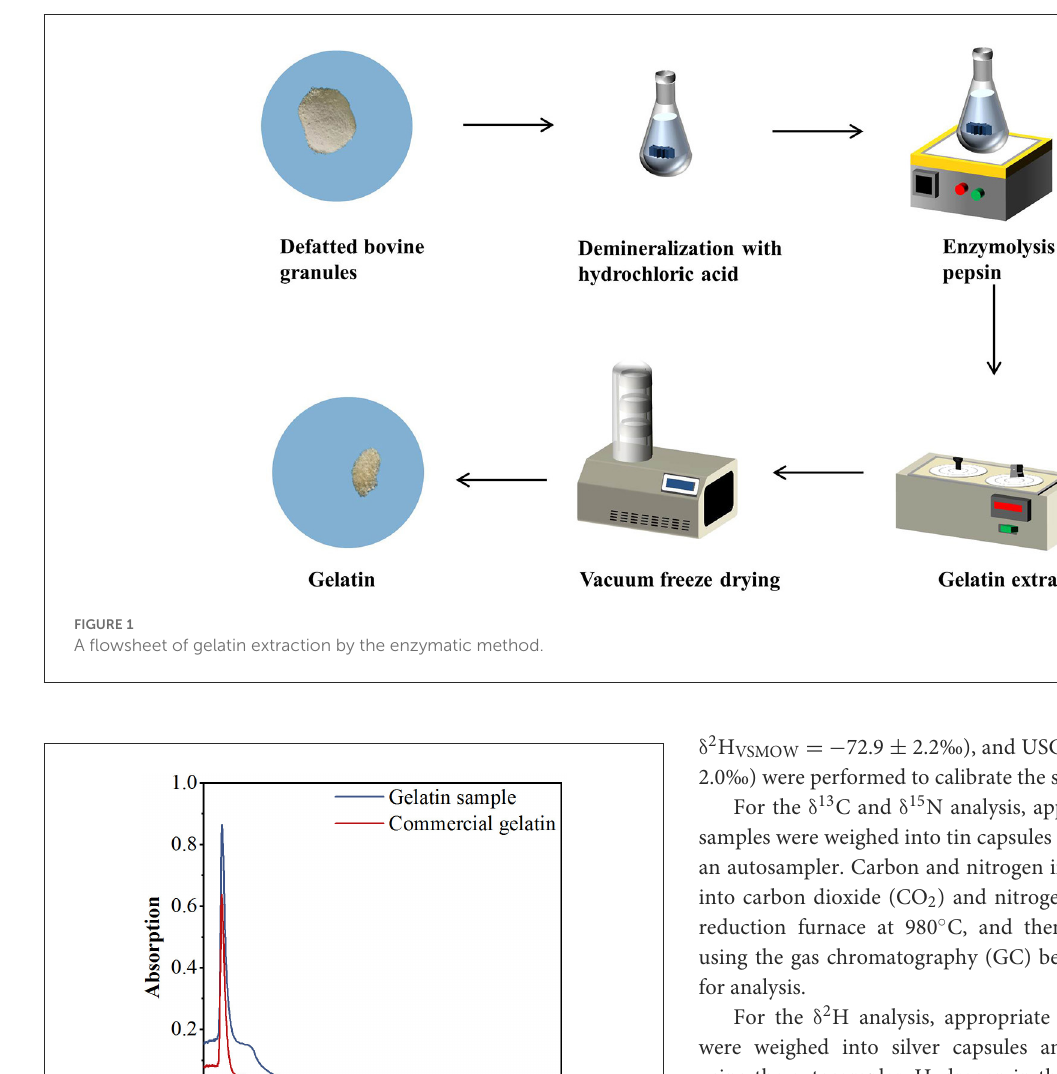
FIGURE2 Ultraviolet (UV) spectra of the gelatin sample (GS) and commercial gelatin (CG).